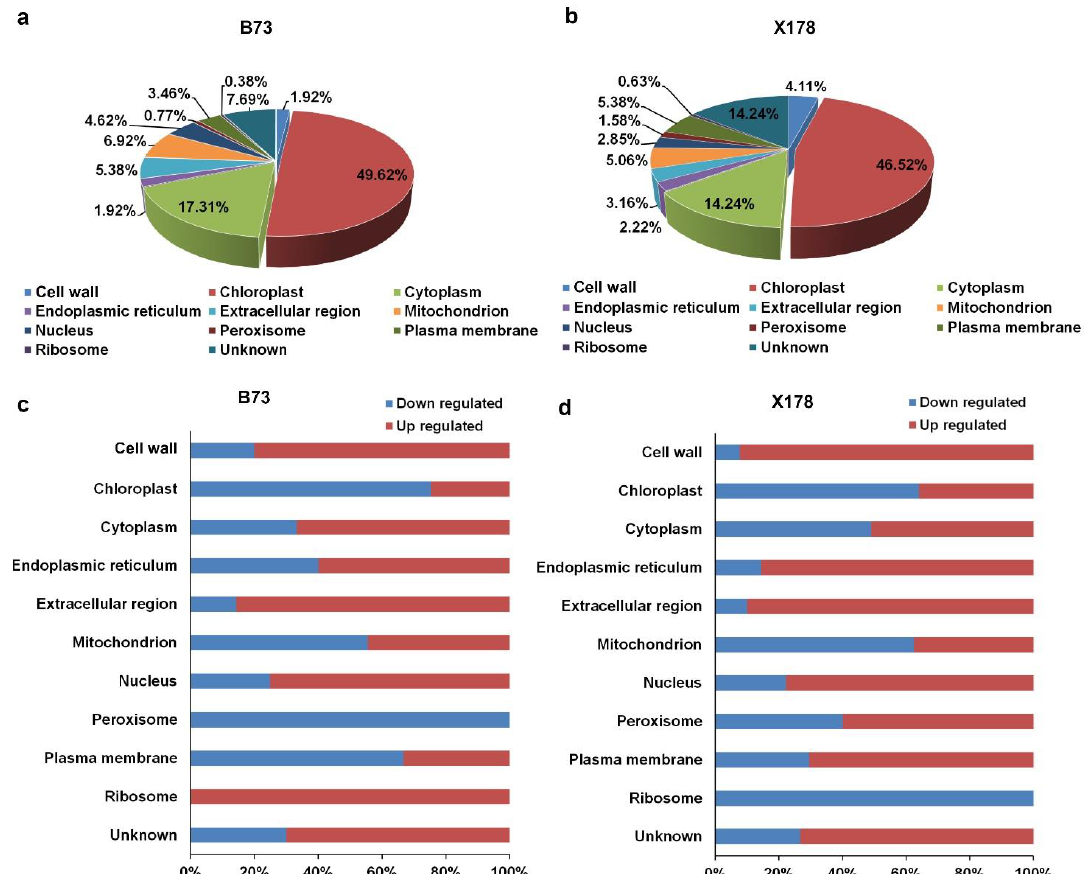
Figure 5. Subcellular localization patterns of DEPs in leaves of maize B73 and X178 following RBSDV infection. ( a , b ) Percentages of DEPs in leaves of RBSDV-infected B73 or X178 in different cell compartments. ( c , d ) Percentages of up- or down-regulated proteins in leaves of RBSDV-infected B73 or X178 in different cell compartments.